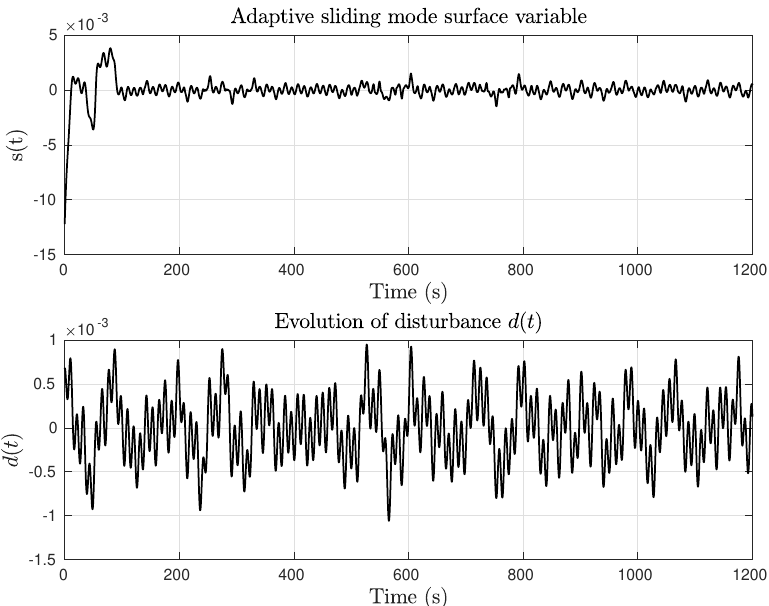
Figure 7. Constant yaw reference test with d ( t ) (cid:54) = 0. Sliding mode variable s ( t ) and external distur- bance d ( t ) .